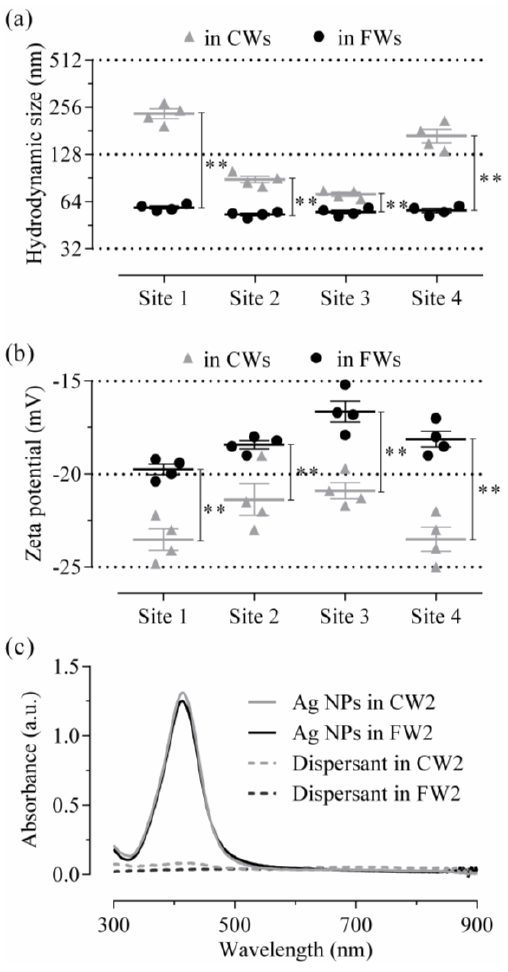
Figure 4. Ag NP characterization in wastewaters. Ag NPs at 10 mg·L −1 in crude and final wastewaters (CWs and FWs, respectively) were characterized by dynamic light scattering (DLS) and ultraviolet-visible spectroscopy (UV-vis). The hydrodynamic size results are shown in ( a ). The zeta potential data are plotted in ( b ). Data are in both cases mean ˘ SEM ( n = 4), significantly different by unpaired t-test with p < 0.05 (**). In ( c ) is shown an example of typical spectra of absorbance (between 300 and 900 nm) obtained for spiked FWs and CWs from Site